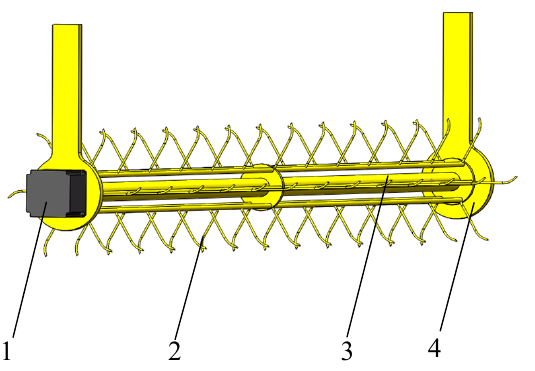
Figure 4. The 3D structure of the disturbing roller. 1. Electrical machine; 2. Spring-teeth; 3. Rotation shaft; 4. Support frame.